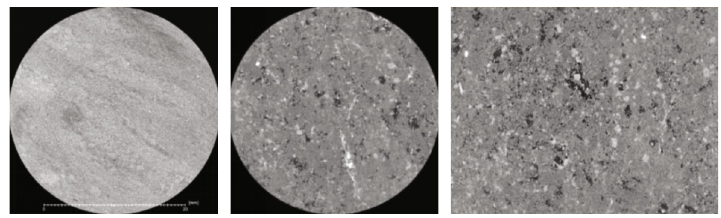
Figure 11: CT scan images of rock